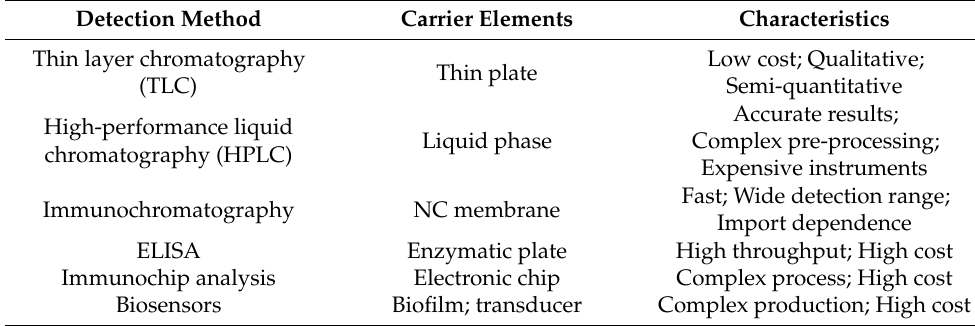
Table 3. Carrier elements and characteristics of AFB 1 detection method.